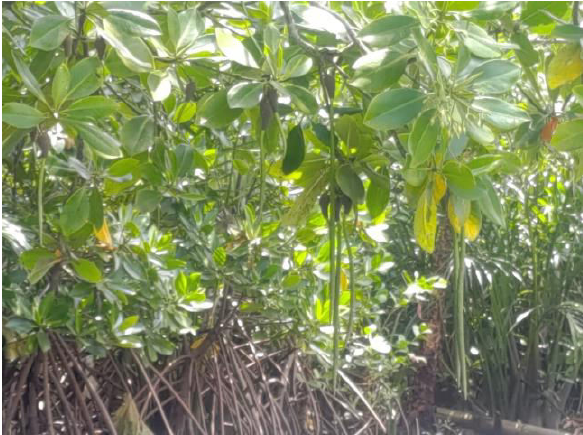
Figure 6 . Photo of an R. apiculata mangrove forest captured during the site visit.